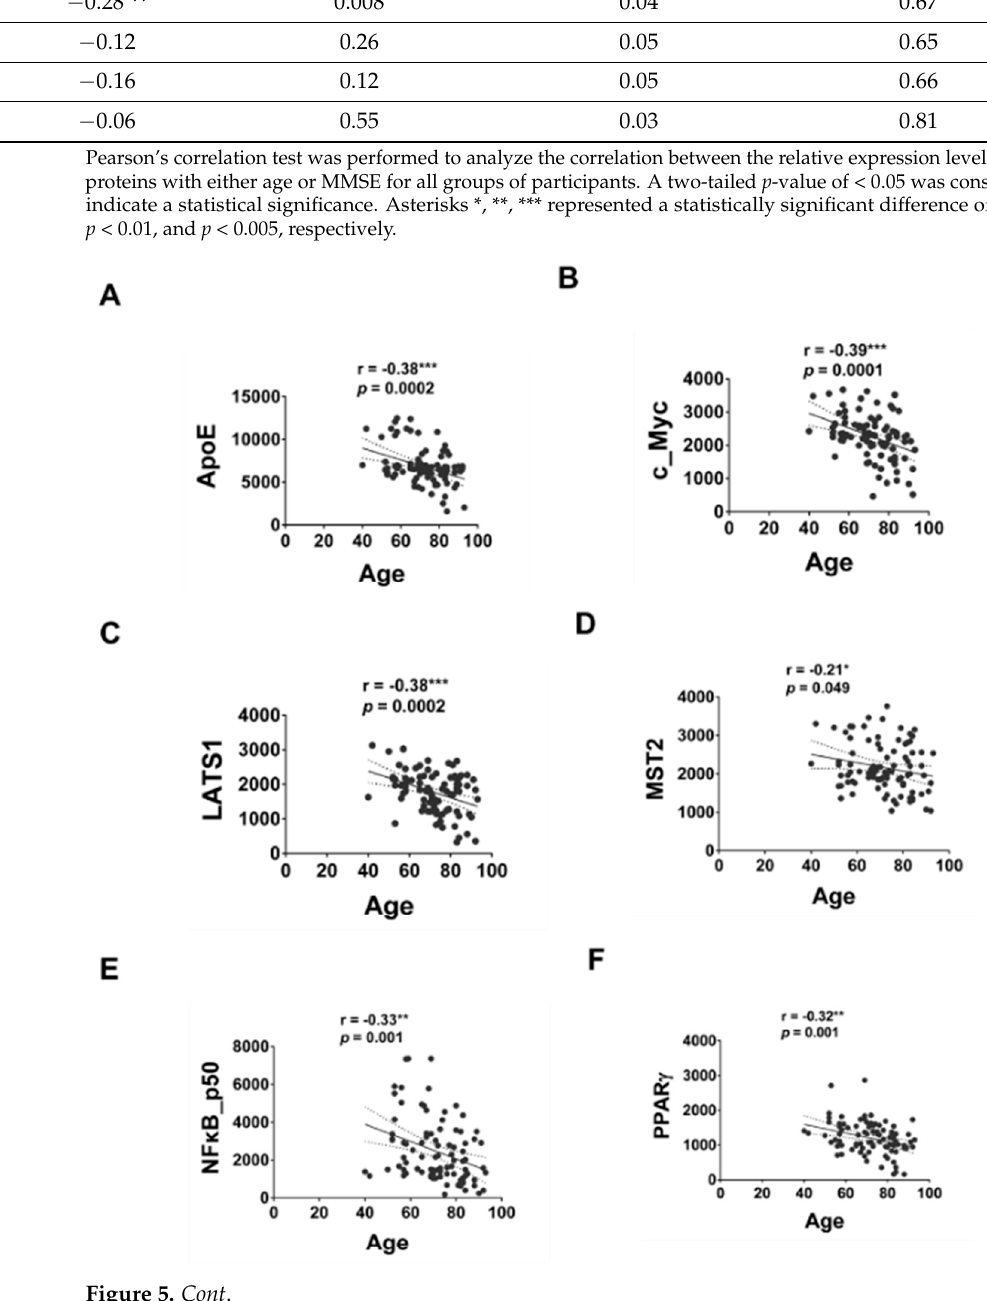
Figure 5. The correlation of expression levels of serum protein and age. Pearson’s correlation test was performed to analyze the correlation between the relative expression level of serum proteins with age for all groups of participants. A two-tailed p -value of <0.05 was considered to indicate a statistical significance. Proteins with statistically significant correlation with age was shown for ApoE ( A ), c_Myc ( B ), LATS1 ( C ), MST2 ( D ), NF κ B_p50 ( E ), PPAR γ ( F ) and SREBP1 ( G ). Asterisks *, **, *** represented a statistically significant difference of p < 0.05, p < 0.01, and p < 0.005, respec- tively.